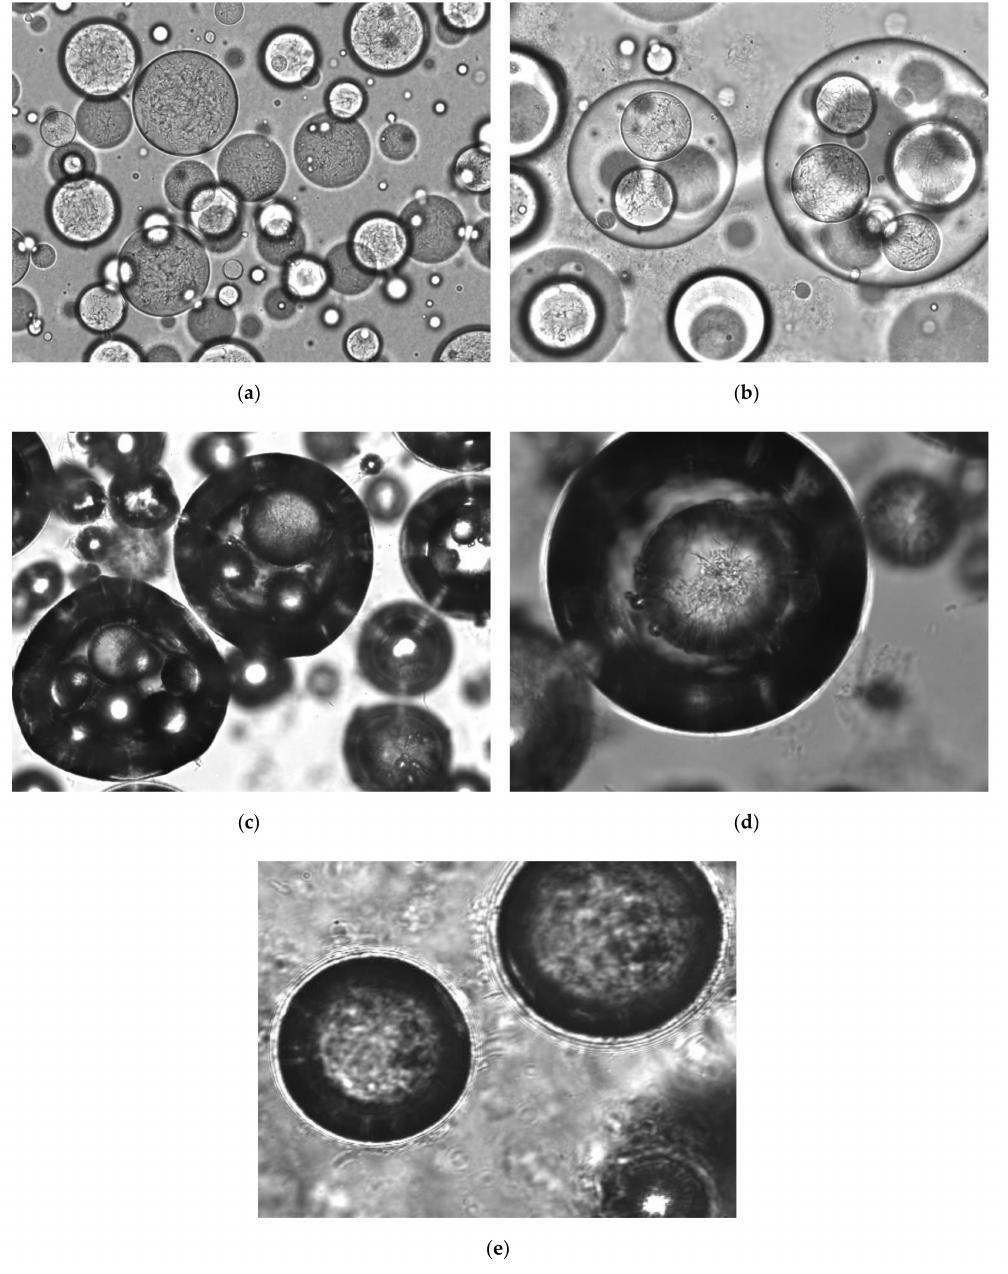
Figure 2. Optical micrographs of the structure and stepwise production of the antibubbles using decane and 10% maltodextrin + 8% sucrose. ( a ) Pickering-stabilized W / O emulsion; ( b ) Pickering-stabilized W / O / W emulsion; ( c ) Antibubbles generated after freeze-drying the W / O / W emulsion and reconstituting the resulting material; ( d ) as ( c ) but with a higher magnification; ( e ) Antibubbles after the addition of bile salt. Scale bar represents 25 µ m (panel d) or 50 µ m (other